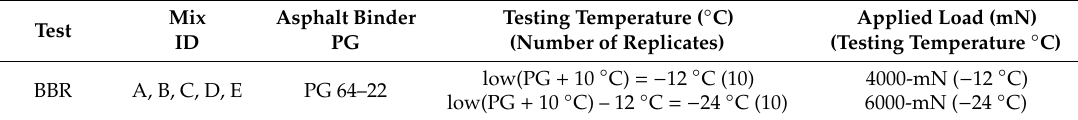
Figure 3. Testing setup of bending beam rheometer (BBR) mixture creep test: ( a ) BBR testing device, ( b ) mixture beam sample. Table 2. Schematic information for BBR mixture testing.